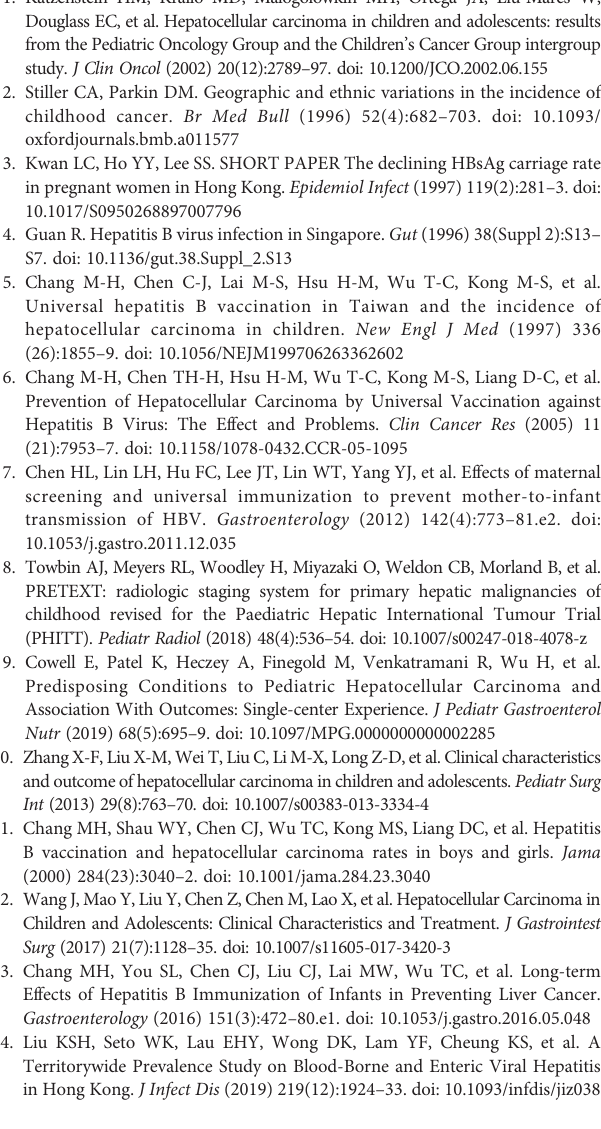
SUPPLEMENTARY FIGURE 1 | Relationship between patient ’ s HBV serology, maternal HBV serology and HBV vaccination. HBsAg, hepatitis B surface antigen; mat, maternal; NA, not available, pt, paternal. SUPPLEMENTARY TABLE 1 | Demographics, clinical characteristics, treatment and outcome of the study cohort.